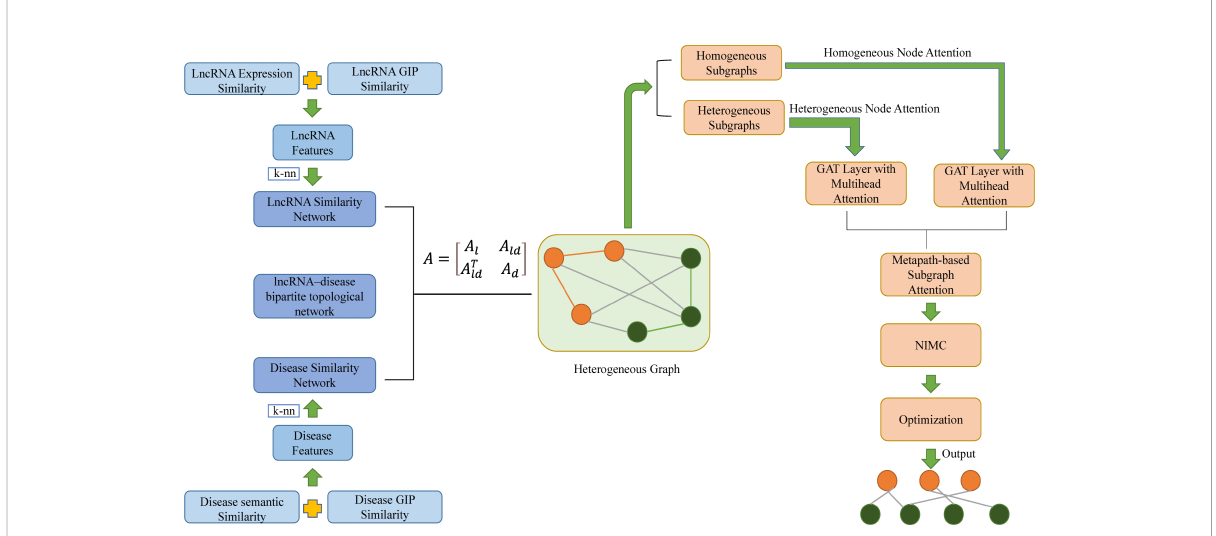
FIGURE 8 The work fl ow of predicting lncRNA-disease associations by heterogeneous graph attention network framework based on meta-paths